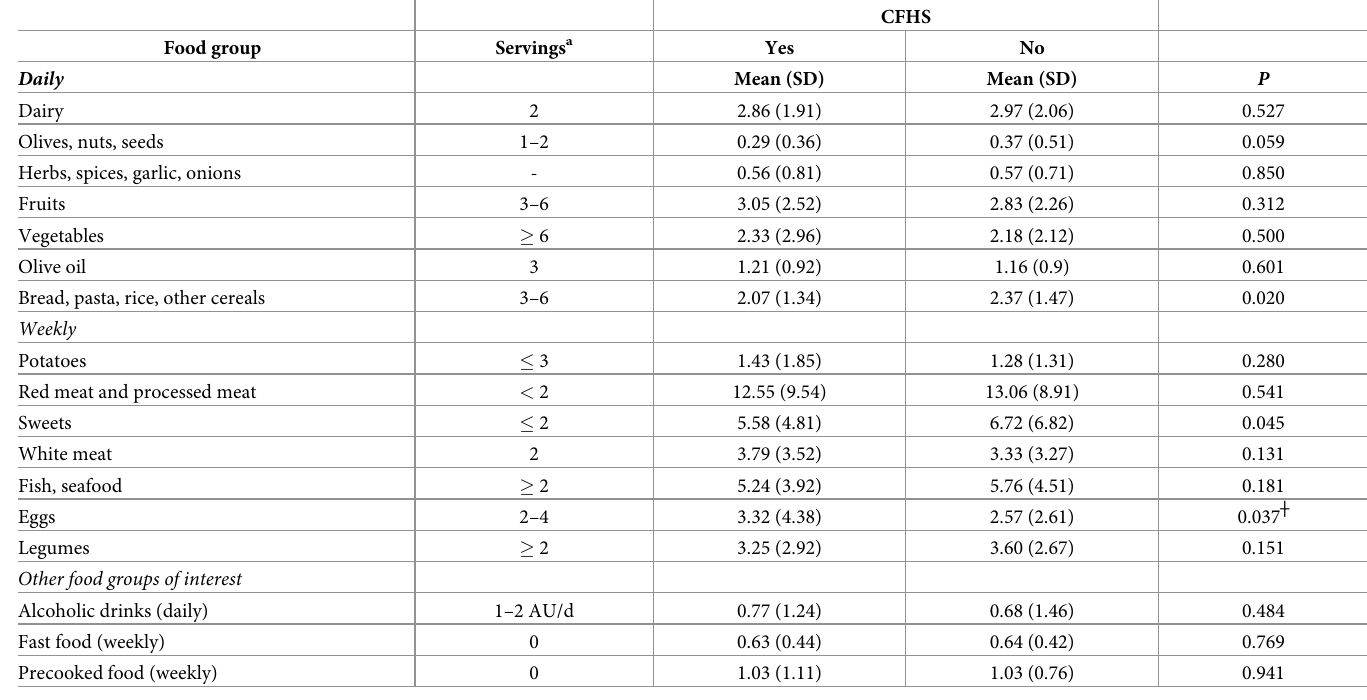
Table 5. Mean differences in food group consumption depending on whether students cook for themselves or not ( n =